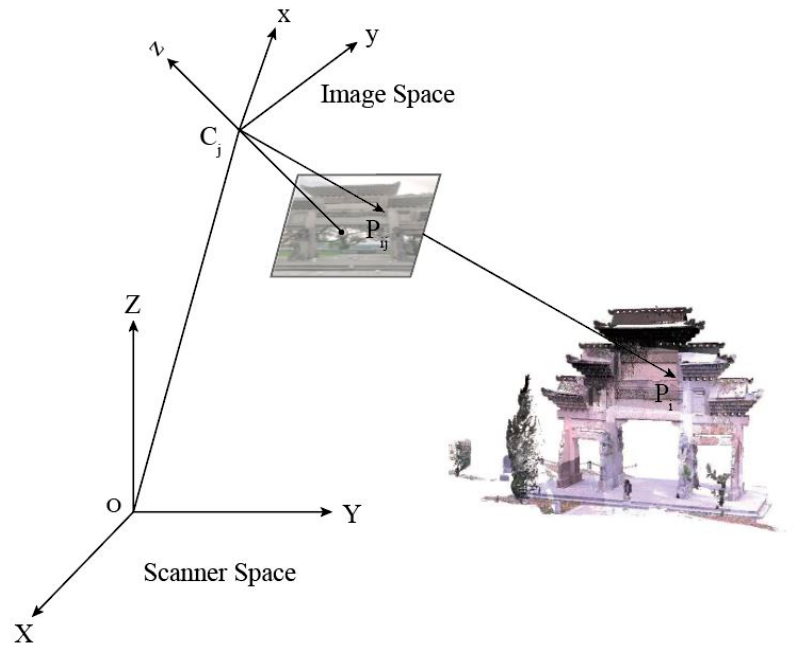
Figure 1. Spatial relationship between the scanner space and the image space.